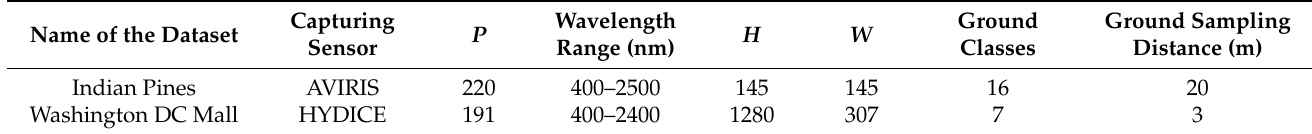
Table 3. Summary of the